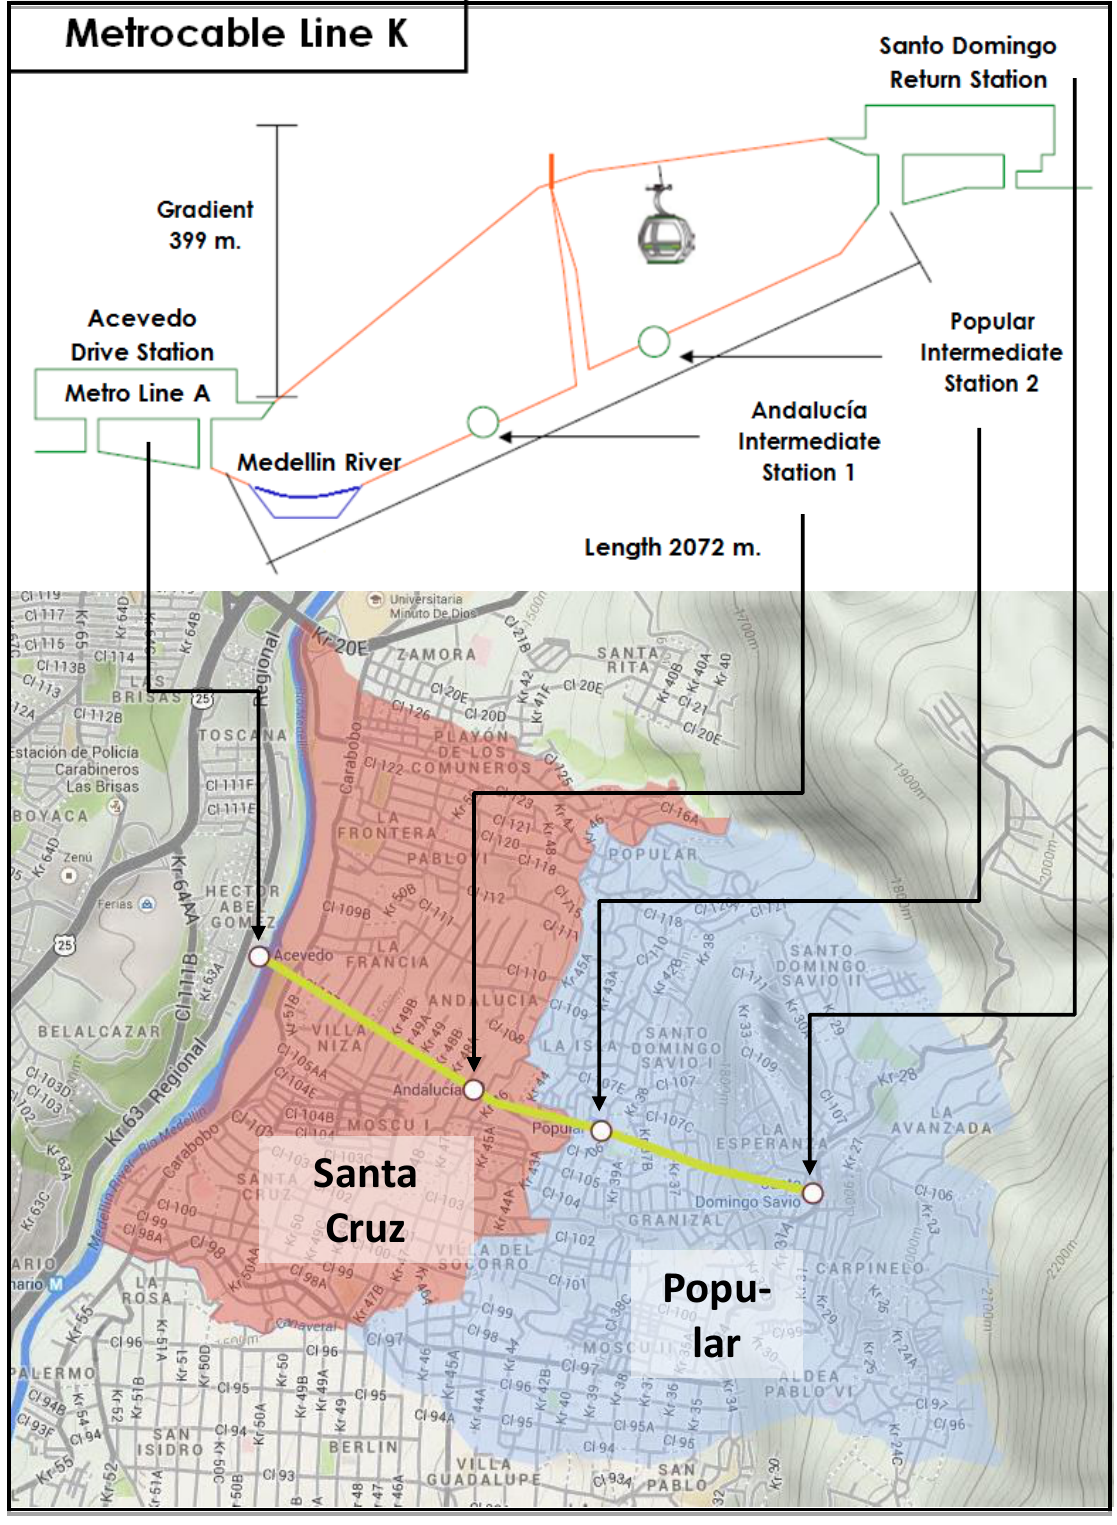
Figure 3. Diagram and Location of Metrocable Line K. Source: Metro de Medellín,